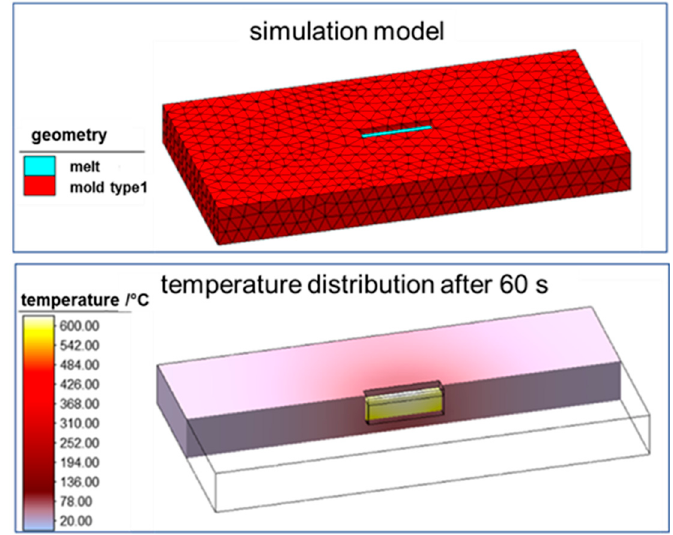
Figure 13. Simulation setup and simulation of the temperature distribution after 60 s.